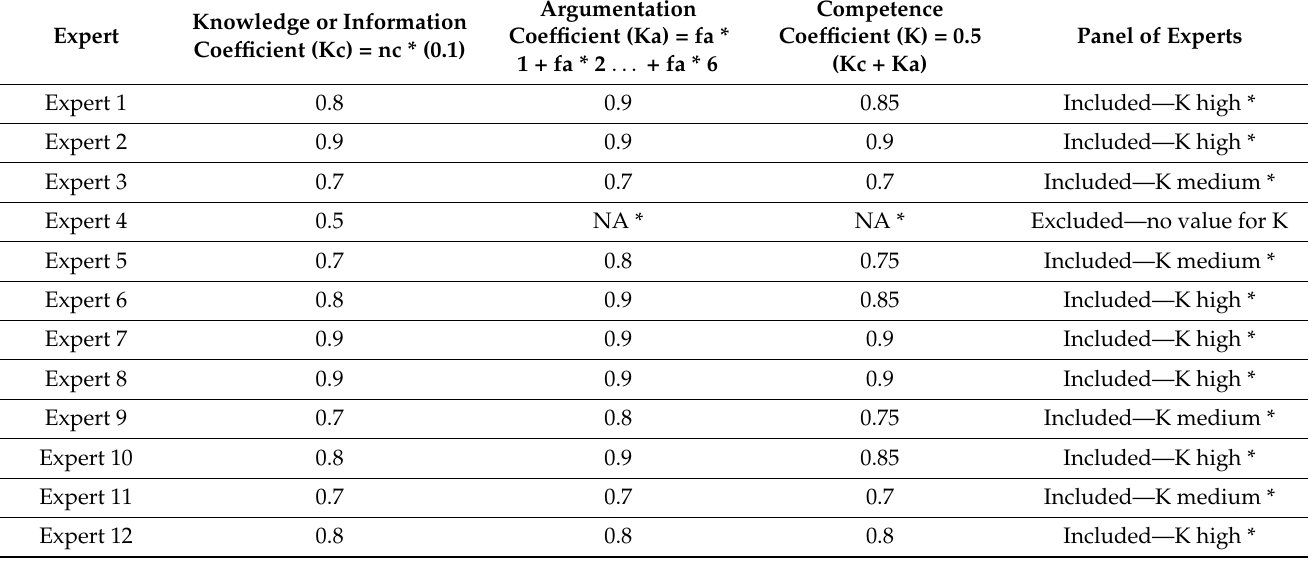
Table 3. Result of the Competence Coefficient (K) of the panel of Experts.